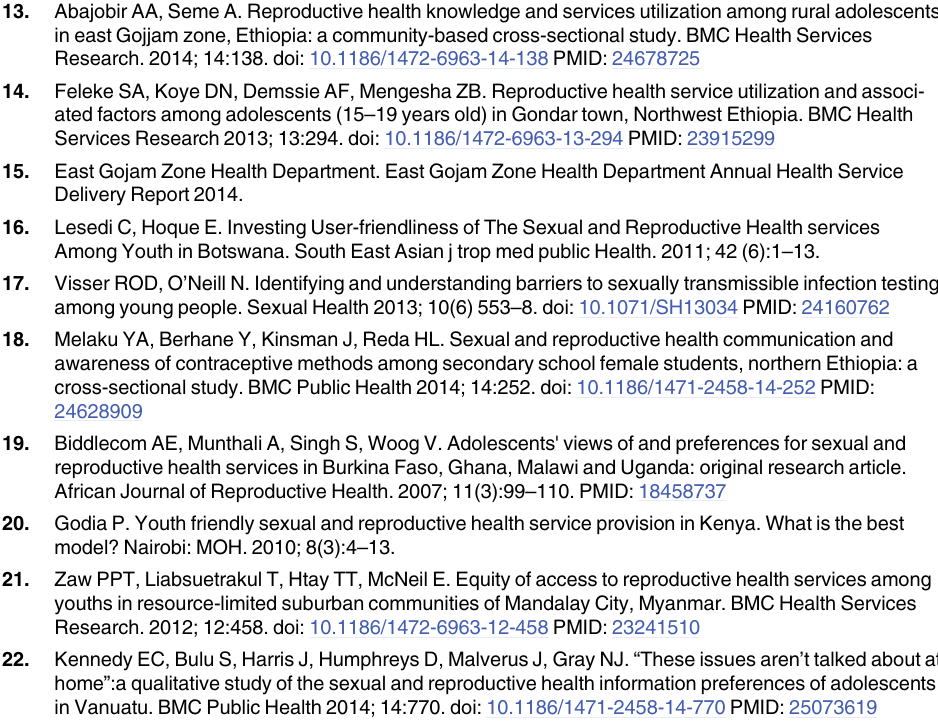
PLOS ONE | DOI:10.1371/journal.pone.0151613 March 18,